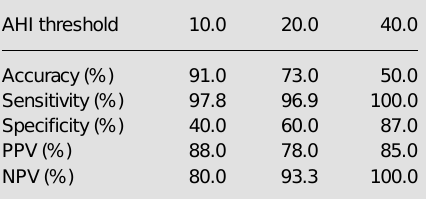
Table 1 - Accuracy, sensitivity, specificity, and posi- tive (PPV) and negative predictive values (NPV) of AutoSet™ as compared to Oxford PSG in patients suspected to have